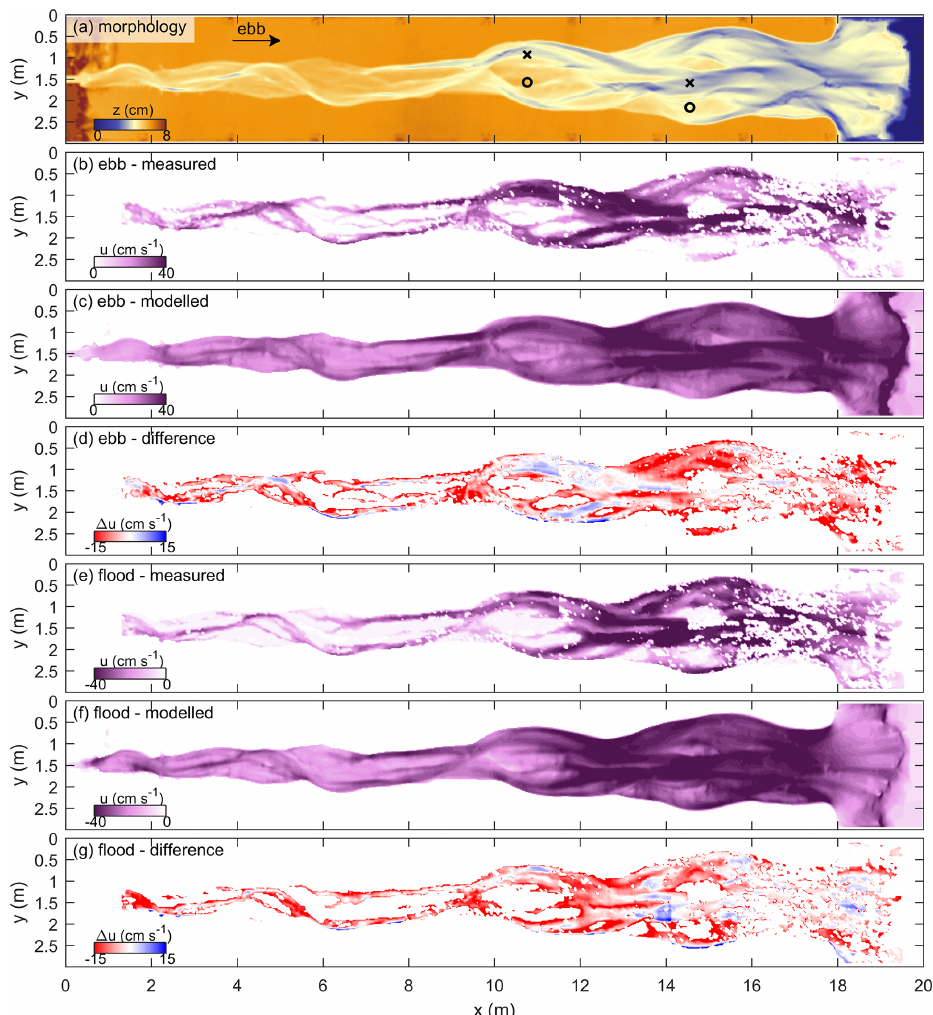
Figure 6. (b–d) Maximum ebb and (e–g) flood flow velocity with (a) the estuary morphology for reference. Maps of difference are deter- mined by subtraction of modelled from measured surface flow velocity. “X” and “O” in (a) are the locations at which tidal stage diagrams were made in Fig. 8 of channels and shoals,